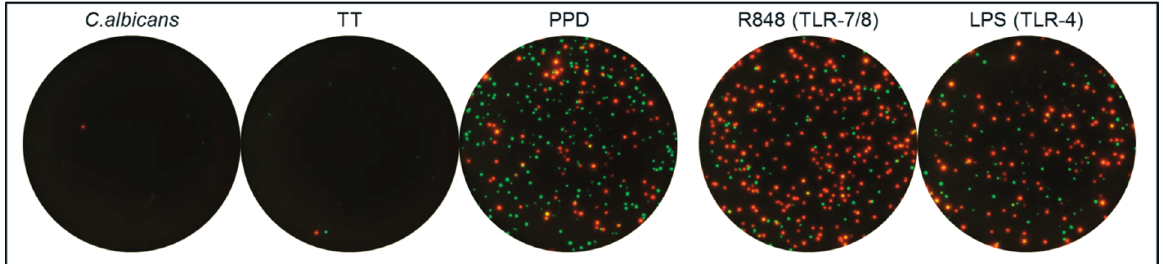
Figure 6. Assessment of the ability of CA, TT and PPD to induce activation of non-T cells. PBMC from two donors were stimulated with CA, TT and PPD and analyzed by a dual IL-6/IL-1 β FluoroSpot. TLR agonists R848 (TLR-7/8) and LPS (TLR-4) were included for comparison. Two thousand five hundred PBMC per well were incubated with antigen or TLR agonist and IL-1 β and IL-6 detected. IL-1 β spots are shown in red and IL-6 spots in green. PPD and R848 yielded >250 of IL-1 β , IL-6 and IL-1b/IL-6 spots per 2500 PBMC and LPS resulted in >150 spots/2500 PBMC. In contrast, PBMC incubated with CA, TT or medium alone (not shown) resulted in a total number of <6 spots/2500 PBMC. The experiment was repeated with other PBMC donors with similar